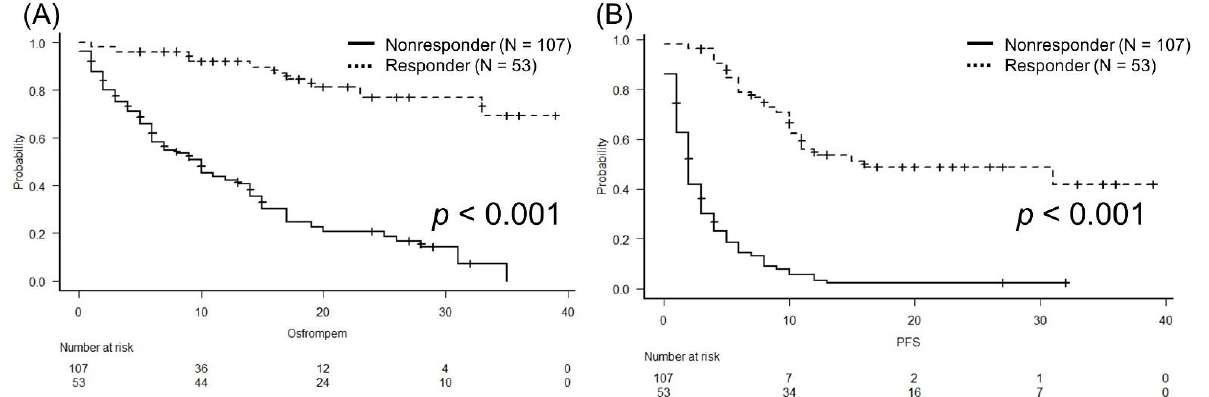
Figure 2. Analysis of overall survival (OS) ( A ) and progression-free survival (PFS) ( B ) according to